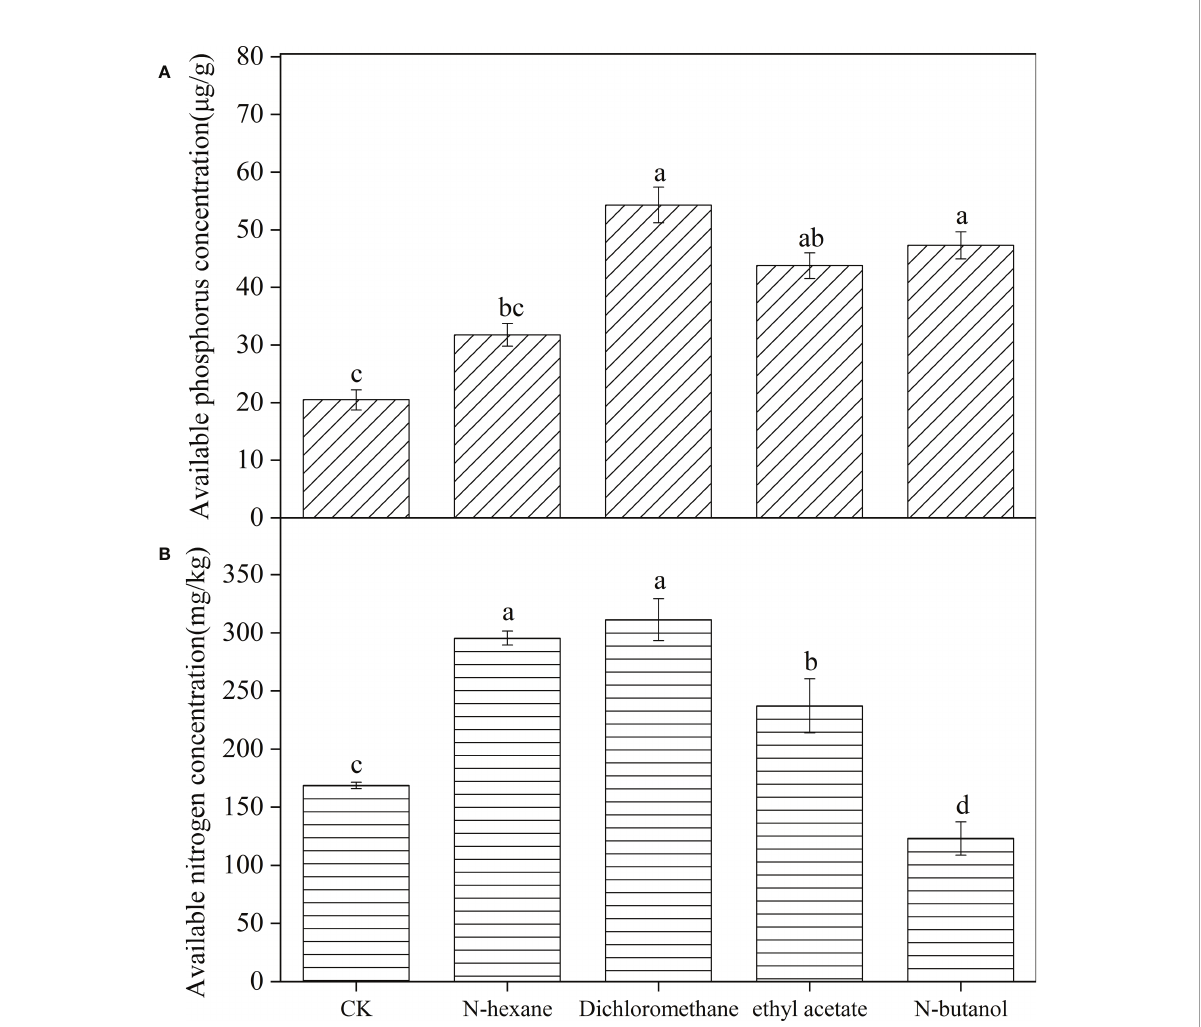
FIGURE 3 Effect of B . frigoritolerans on soil available phosphorus (A) and effect of B . megaterium on soil available nitrogen (B) , after being treated with different extraction phases of root exudates. Different lowercase letters indicate that the same strain with different extracts treatments has signi fi cant differences at the P < 0.05